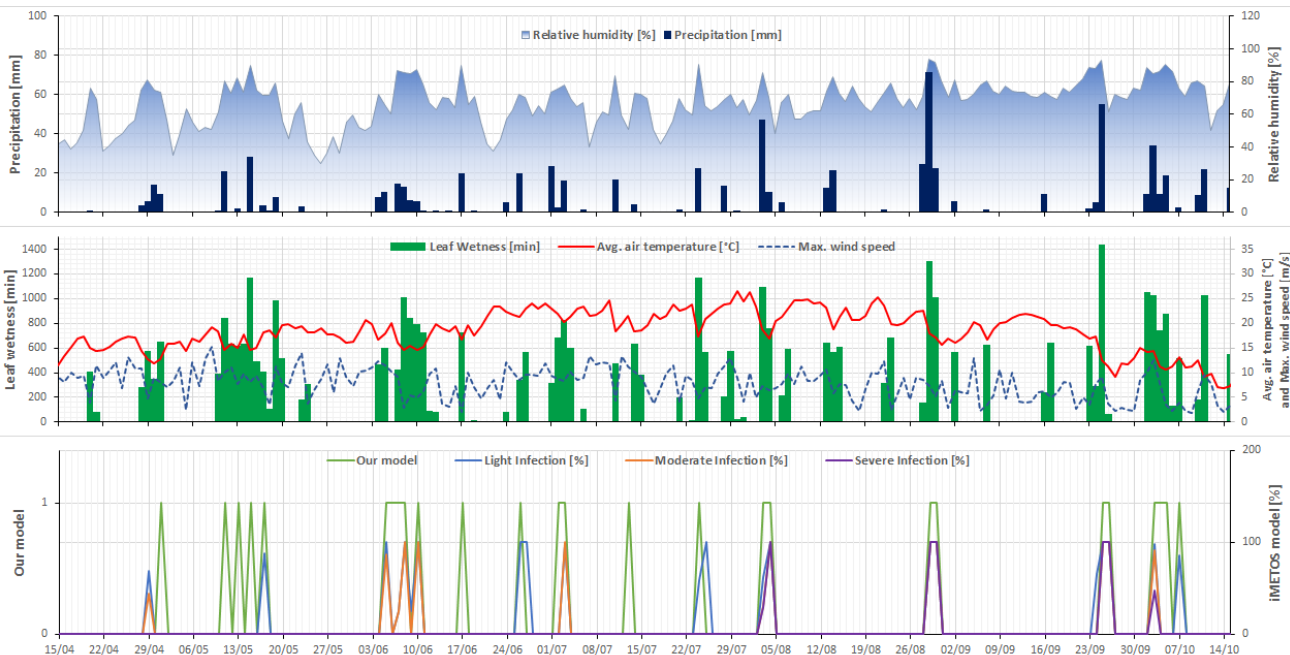
Figure 15. Primary infection alarms for the location ’Trient’.